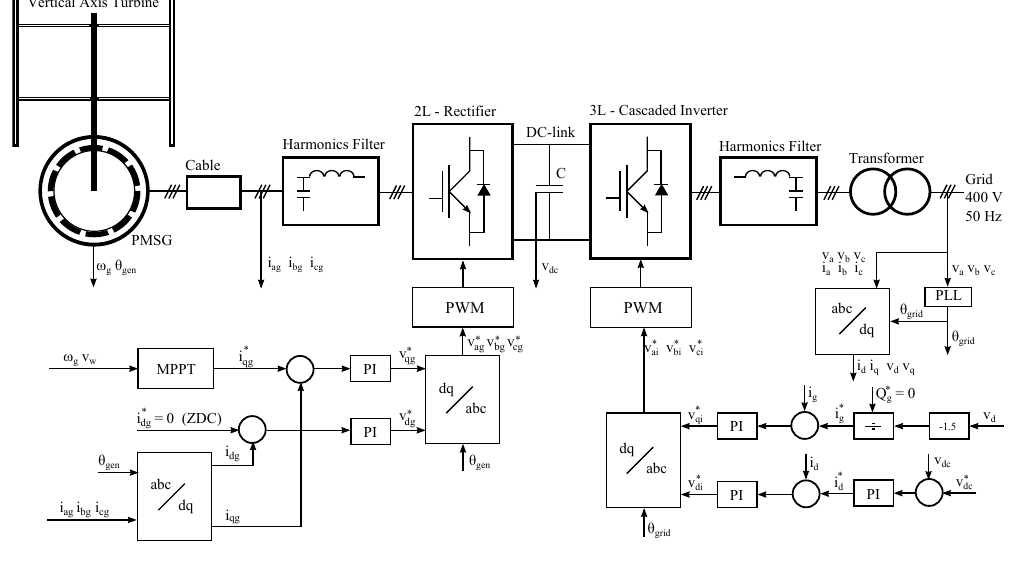
Figure 4. Control scheme overview for the grid connection system for the marine current energy